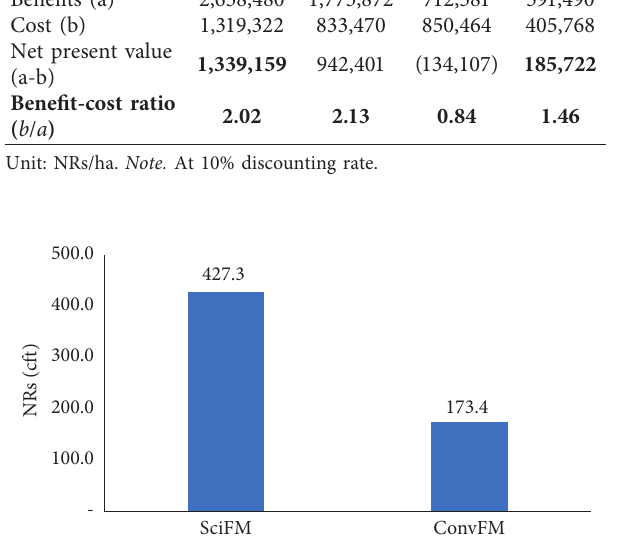
Figure 1: Timber production cost in two forest management